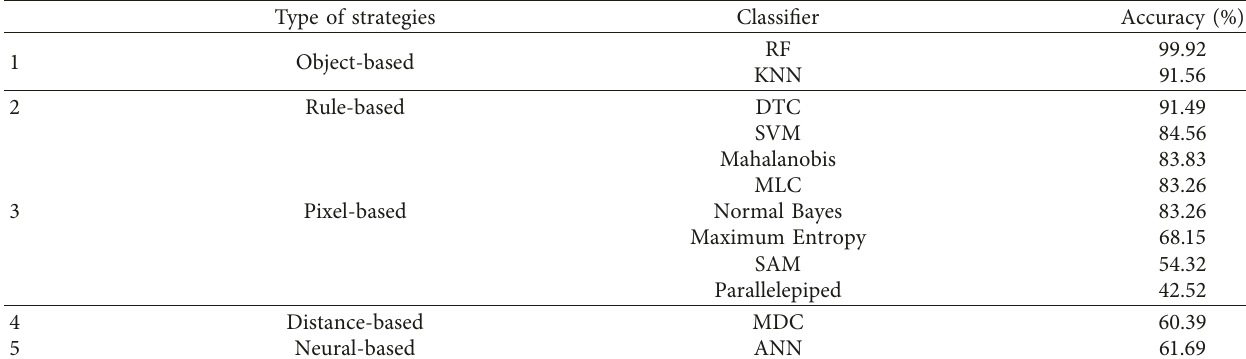
Table 7: Overall accuracy for classifiers with Sentinel-2A